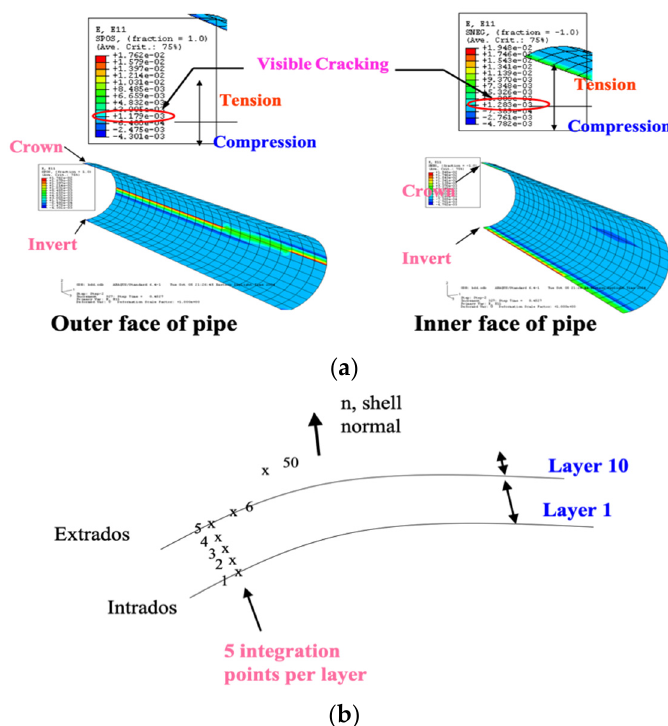
Figure 3. Crack analysis method: ( a ) crack detection and ( b ) crack depth.